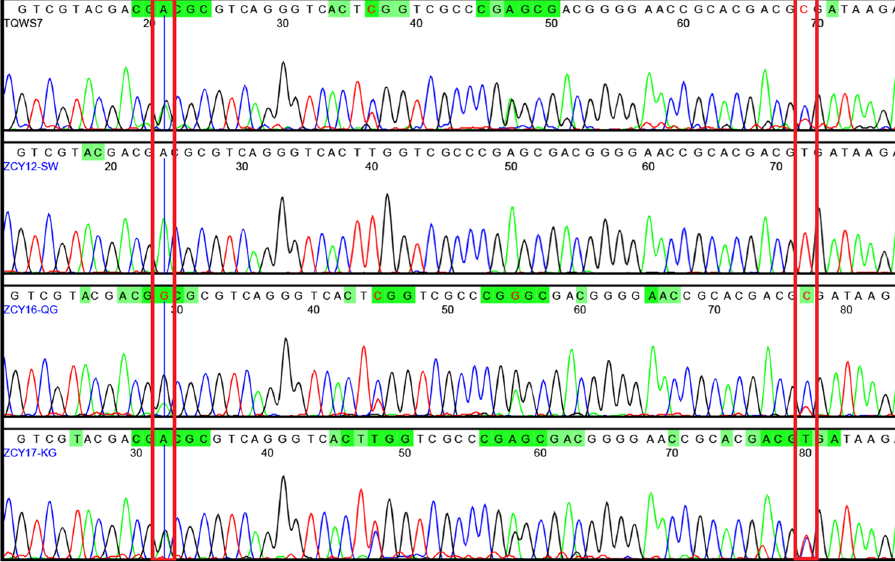
Figure 5. Double peaks at SNPs of adulterants of plant extracts and Chinese patent medicines. Note: One extracts (TQW 17) and three CPMs (ZCY12,16,17) were picked to demonstrate the SNP double peak methods. Two SNP sites were framed in this peak profile,